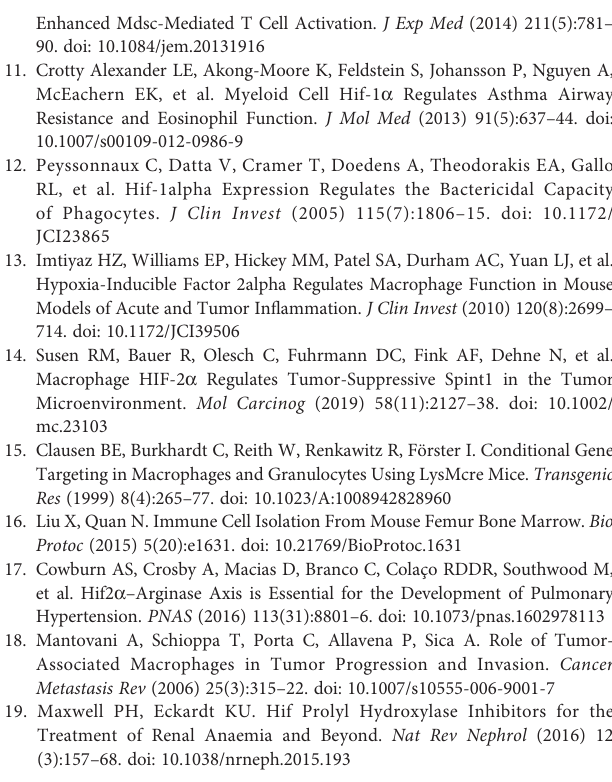
Supplementary Figure 1 | The antigen presenting assay. (A) Illustration of the in vitro antigen presenting assay. Bone marrow derived myeloid cells (BMDM) were activated with 100 ng/mL LPS for one day, followed by 1-hour incubation with 100 ng/mL OVA;257-264(SIINFEKL). CellTraceVioletStaining(CTV) stainedCD8 + OT-I T-Cells were co-cultured with BMDMs for 3 days. (B) Representative gating strategy used to analyze BMDMs surface markers, and co-activators and antigen presenting surface proteins were upregulated in BMDMs stimulated with LPS. (C) Gating strategy to measure OT-I T-Cell division and surface markers. Expression level of surface markers was determined on the whole live CD8 + population whereas division level was de fi ned by fraction of divided live CD8 + T-cells. (D) Representative CTV plots of negative and positive controls for antigen presenting assays with division fraction of untreated CD8 + T-cells (negative control)